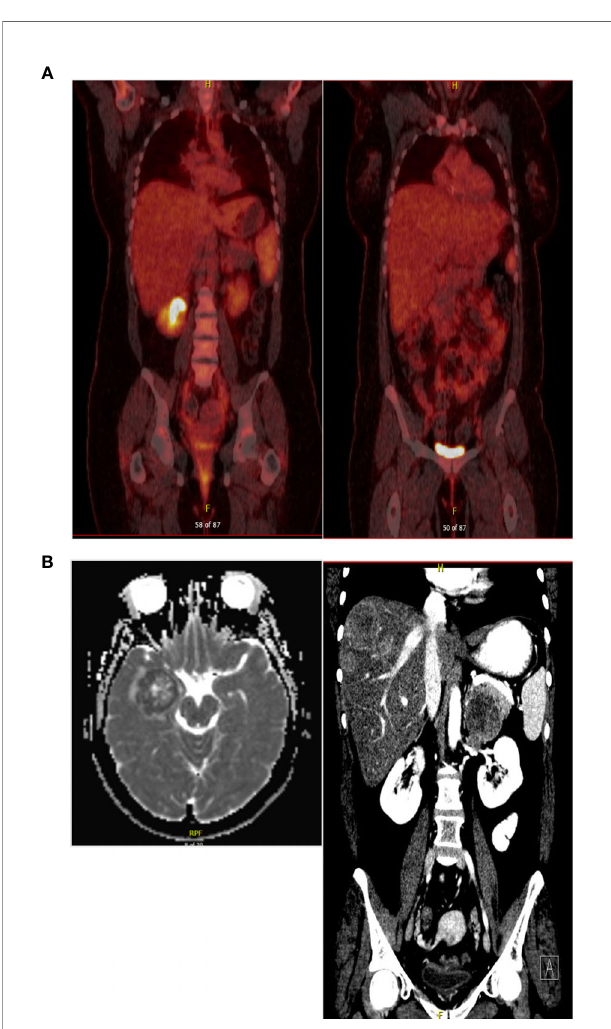
FIGURE 2 | (A) PET/CT scan after completing chemoradiation therapy showed no evidence of disease. (B) At the time of diagnosis of recurrent disease, brain MRI and CT scan of the abdomen con fi rming brain metastasis and multiple hepatic metastatic